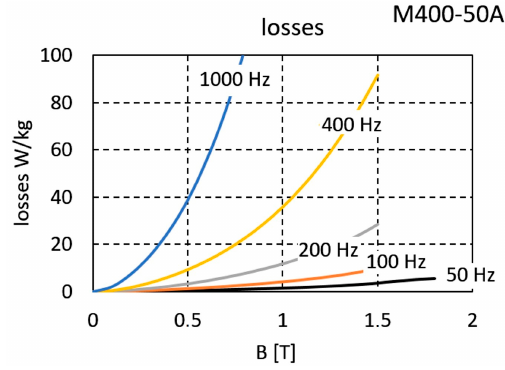
Figure 8. Losses of M400-50A lamination.